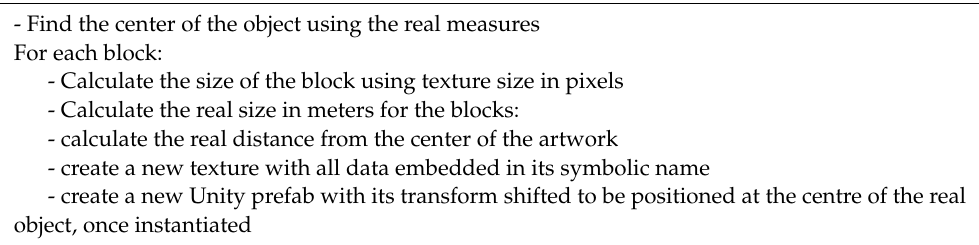
Algorithm 2 Steps involved in the creation of content to be attached to each